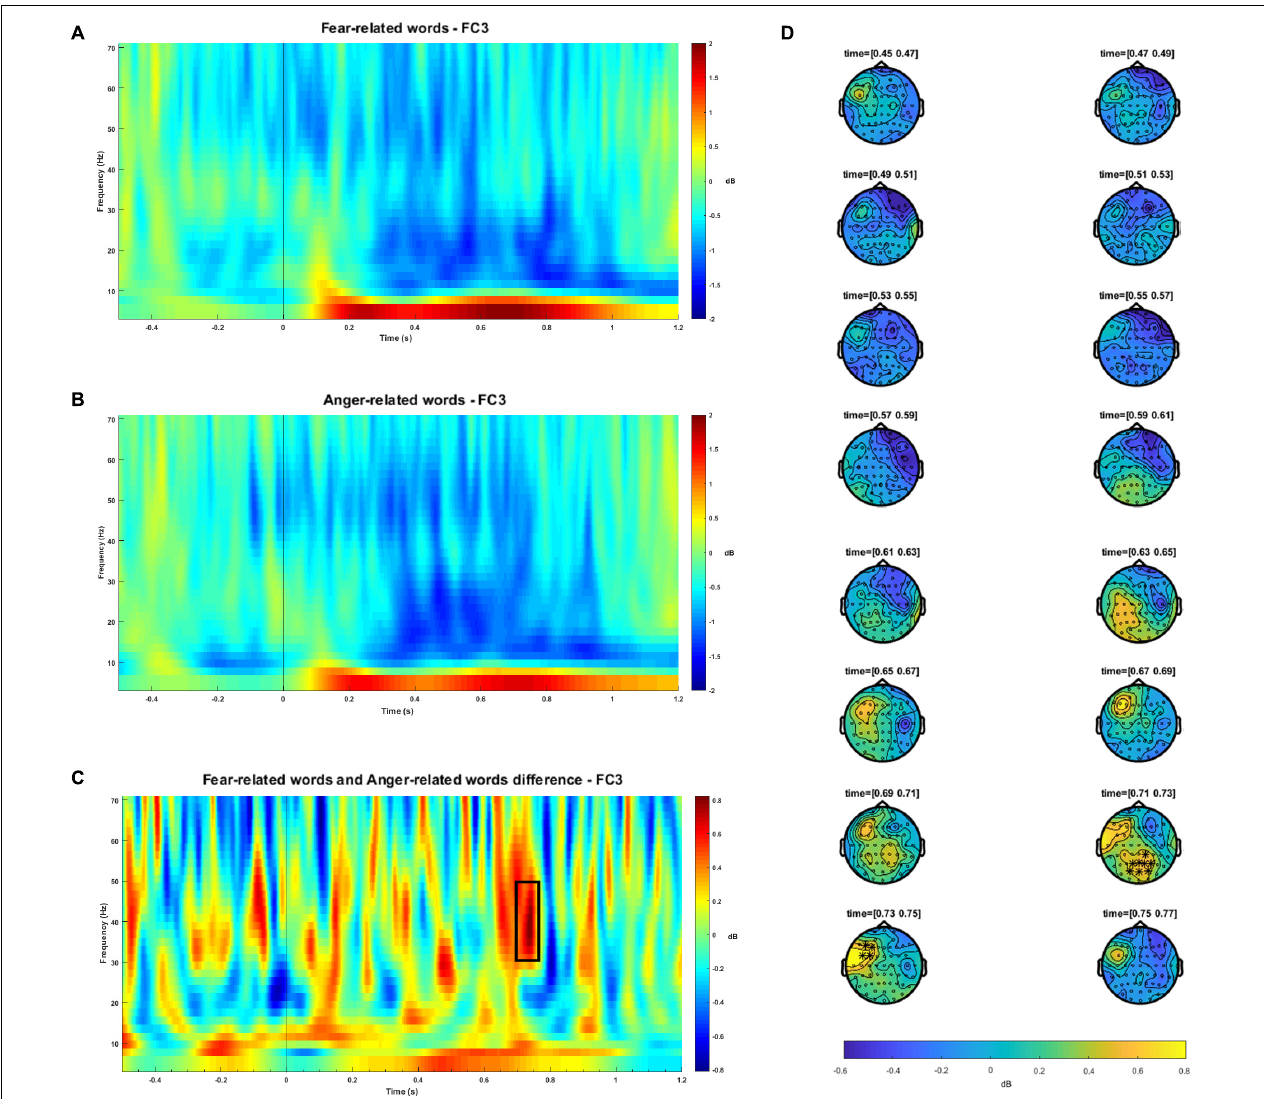
FIGURE 1 | Time-frequency plots for the fear-related words (A) and anger-related words conditions (B) , for 4–70 Hz at a representative electrode location (FC3). To avoid artifact contamination, a -300 to -500 baseline prior stimulus target onset was used. Total power is expressed as decibel transformation relative to baseline. The black vertical line indicates the stimulus onset. (C) Time-frequency plot for the difference between fear-related words and anger-related words at a representative electrode (FC3). The black box highlights both the frequencies and the time range in which significant results were observed. The black vertical line indicates the stimulus onset. (D) Topographic distribution along the time course of the significant clusters observed in the gamma band (30–50 Hz) between fear-related words and anger-related words. Significant electrodes ( p < 0.05) are highlighted with a black star. Color bar represents power difference between conditions, measured in